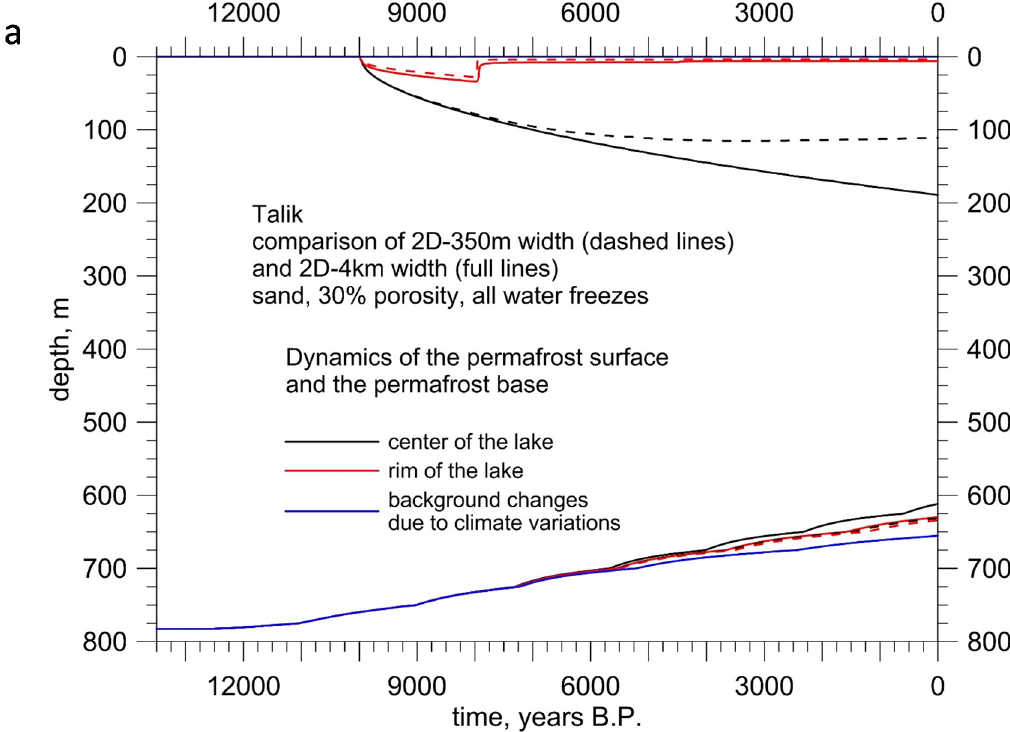
Figure A1. Comparison of 2-D infinite lake model results (full lines) with the axis-symmetric model results (broken lines). The lake size influence is shown below (Figure A2).